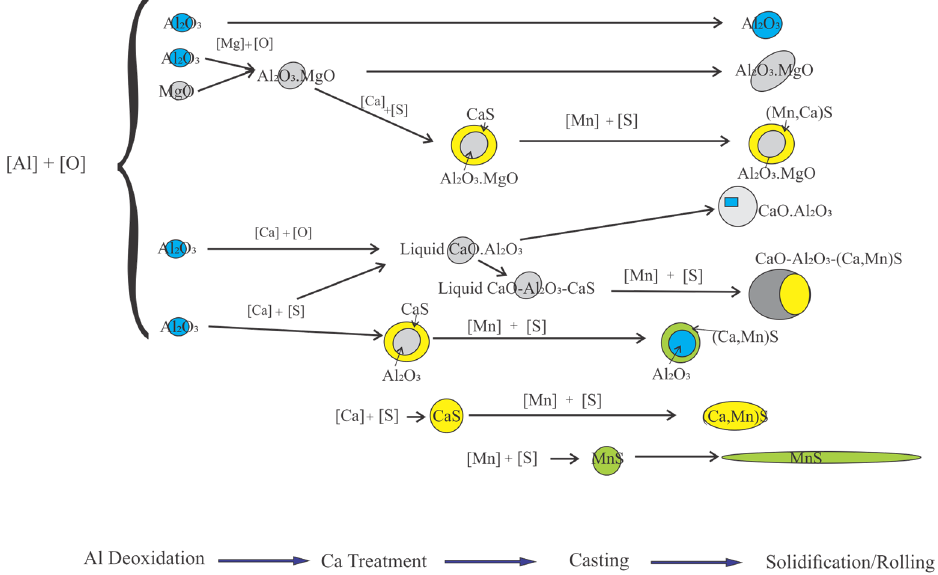
Figure 8. The schematic diagram of inclusions formation at the different stages of Al deoxidation, Ca treatment and solidification.